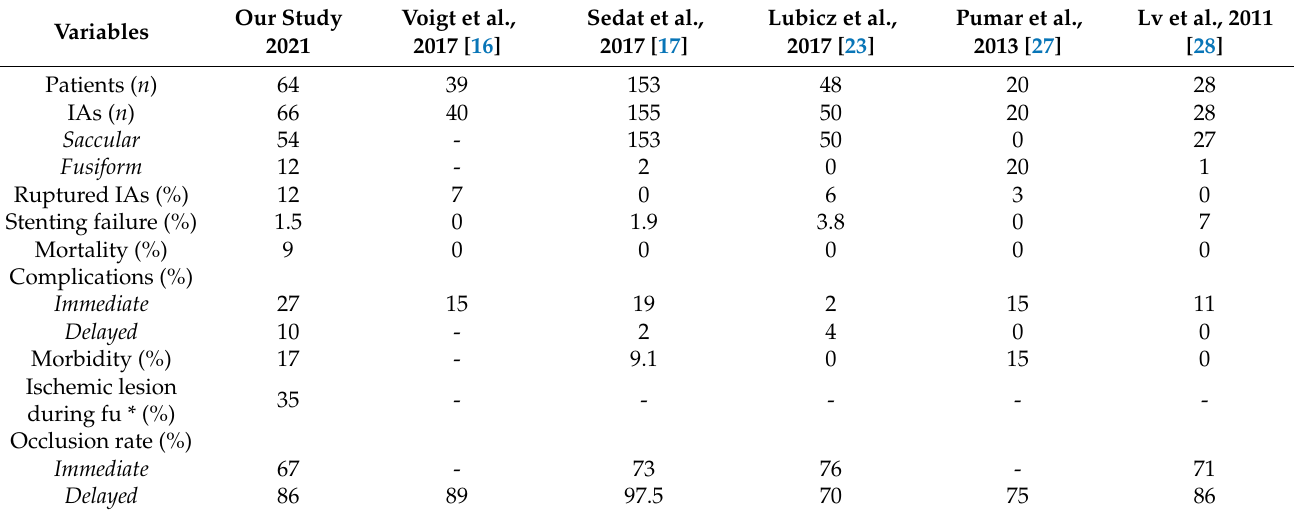
Table 5. Main outcomes of the main series from the literature using Leo stent for treatment of intracranial aneurysms.